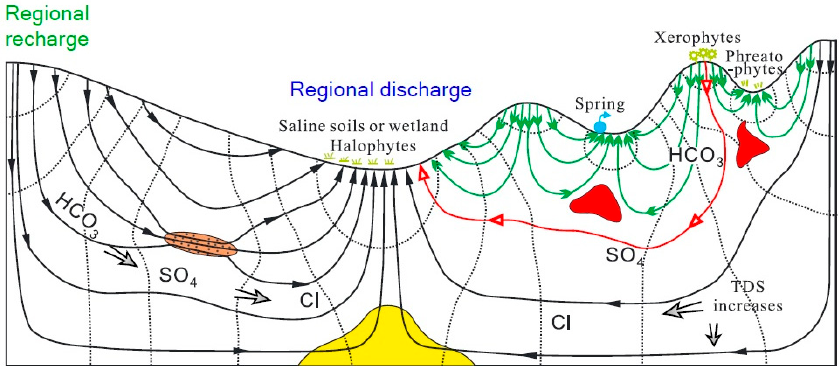
Figure 1. Schematic diagram of groundwater flow systems showing some of the processes and manifestations. The order of flow (local, intermediate, regional) is indicated by the flow lines in green, red, and black, respectively. The two areas in red indicate internal water traps and the yellow area represents a basin floor. The scale depends upon the geological framework.